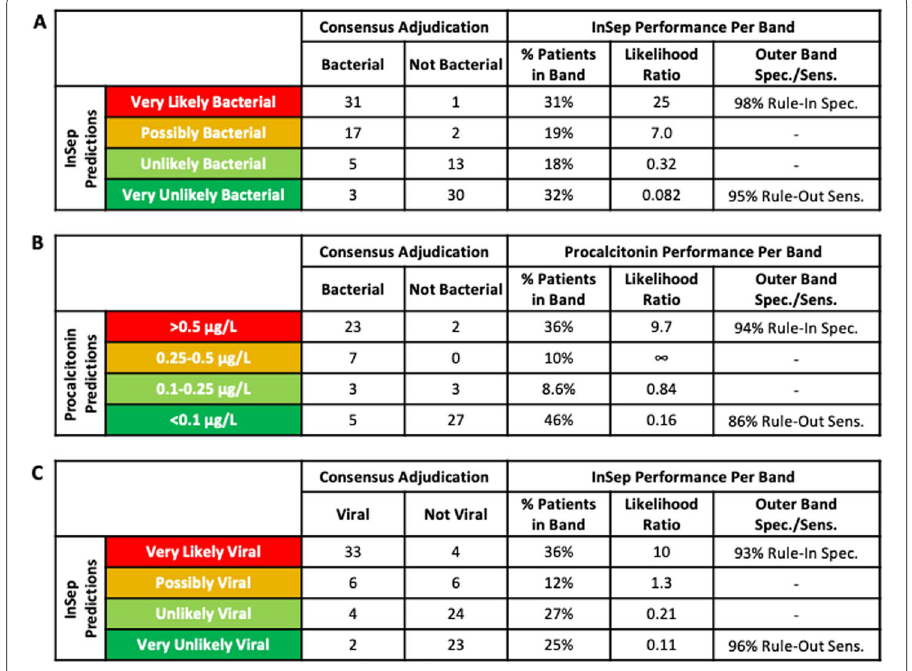
Fig. 3 InSep interpretation bands provide clinically actionable results. a InSep bacterial results in interpretation bands ranging from Very likely, Possibly to Unlikely and Very unlikely. b Performance accuracy for procalcitonin depicted in interpretation bands for different concentration ranges reported in the literature [31]. c InSep viral results in interpretation bands ranging from Very likely, Possibly to Unlikely and Very unlikely